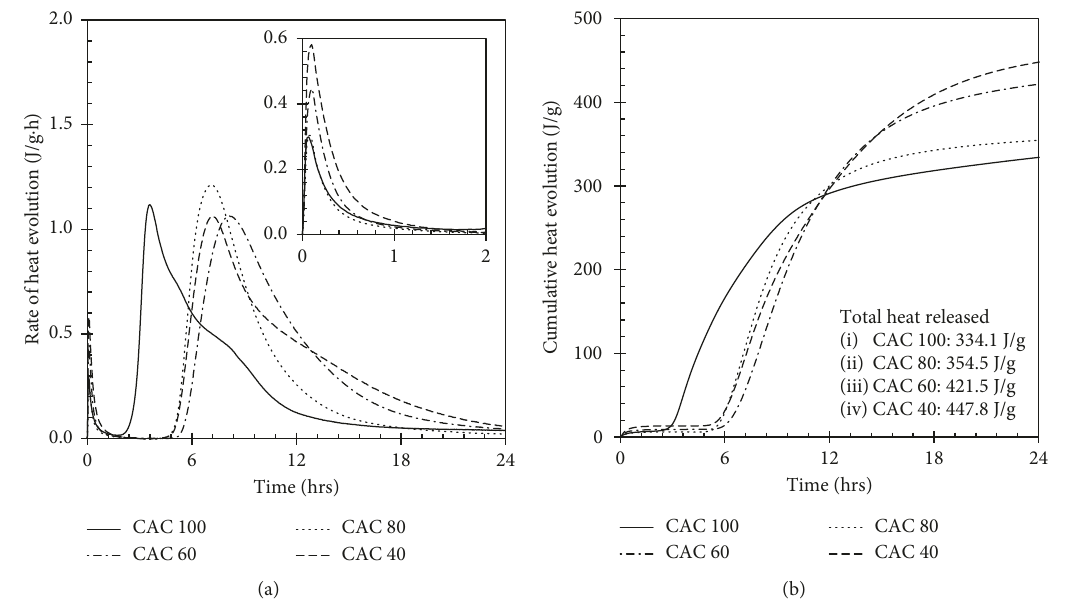
Figure 3: Calorimetric curves normalized to CAC content: (a) rate of heat evolution; (b) cumulative heat